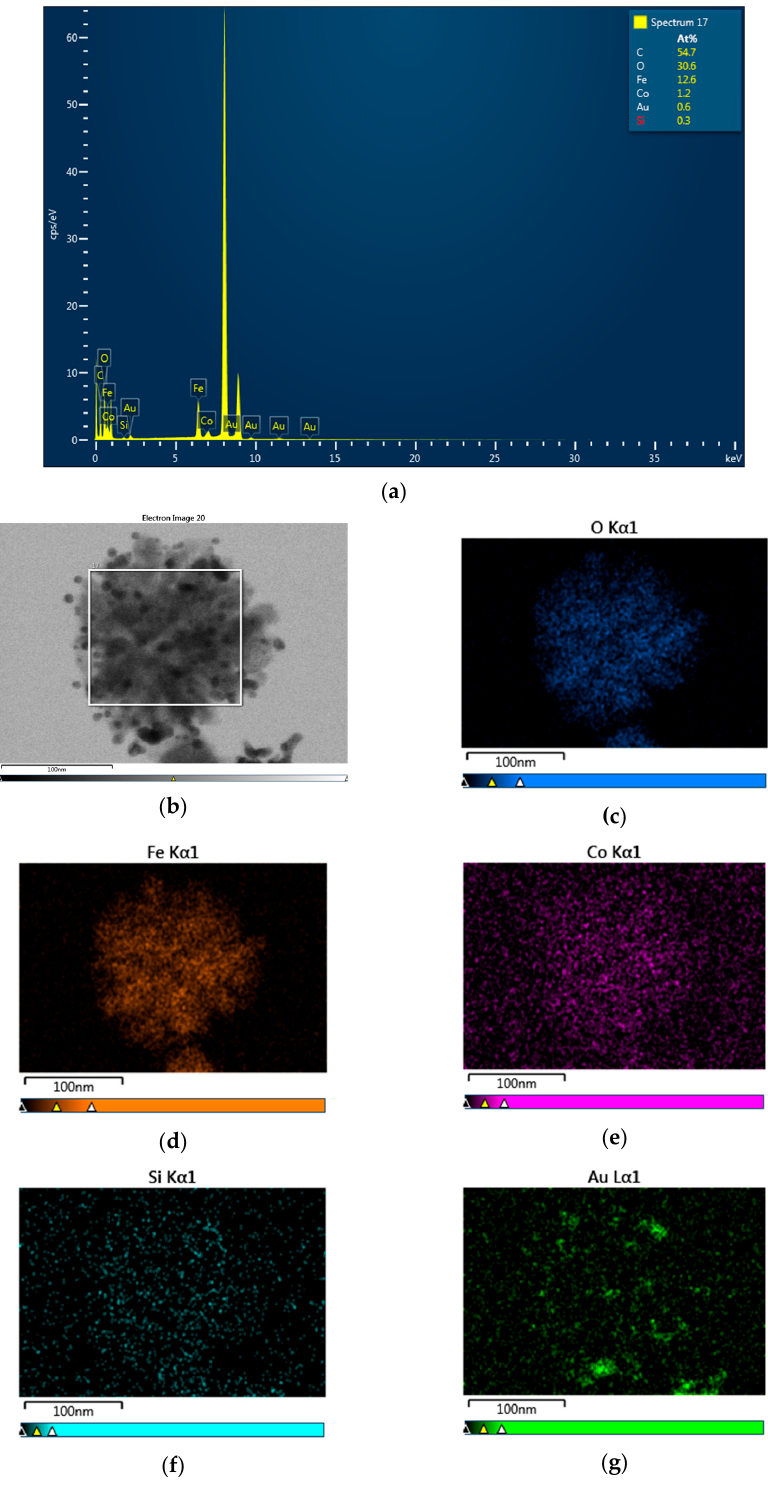
Figure 5. EDS spectrum ( a ), TEM image ( b ) EDS mapping ( c – g ) of CoFe 2 O 4 @SiO 2 @Au 2 nanocompo- site.